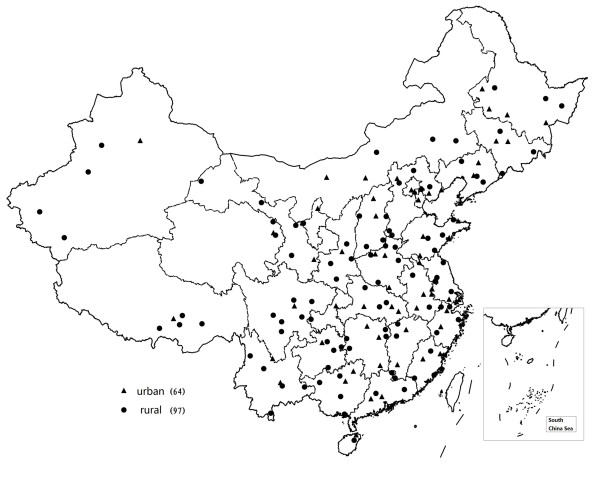
Geographic distribution of Disease Surveillance Points (DSP) system.